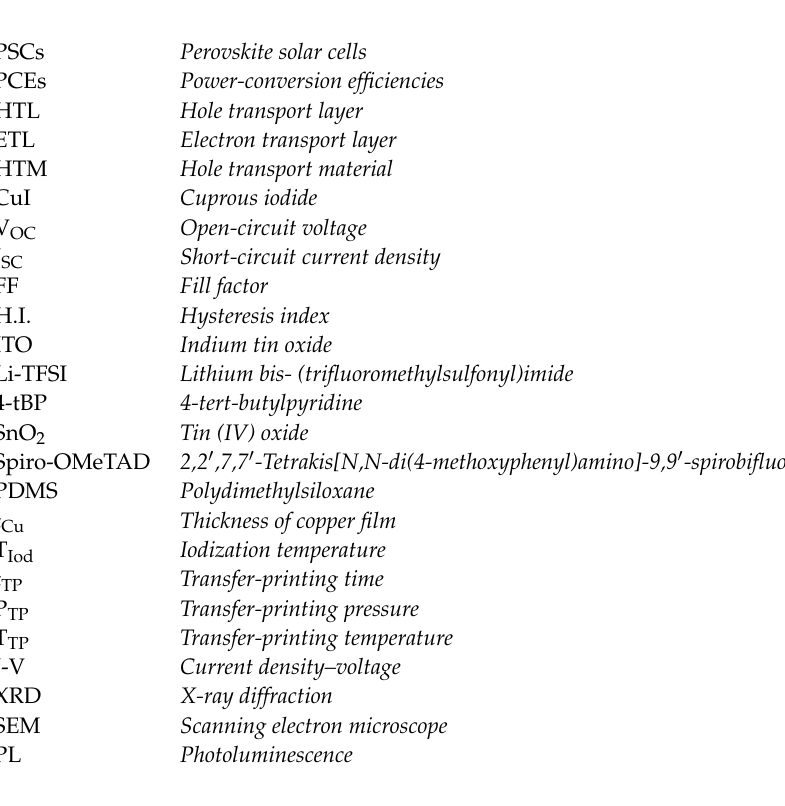
the solar cell device. Figure S6: Schematic of Cu iodization deposited directly on perovskite layer and comparison of solar cell performance. Figure S7: Cost efficiency comparison. Table S1: Comparison of CuI with other dopant-free HTMs for planar SnO 2 -ETL based (n–i–p) PSCs. Table S2: J–V parameter of CuI HTL device transfer-printed at 150 ◦ C. Table S3: Device parameter comparison fabricated with different methods